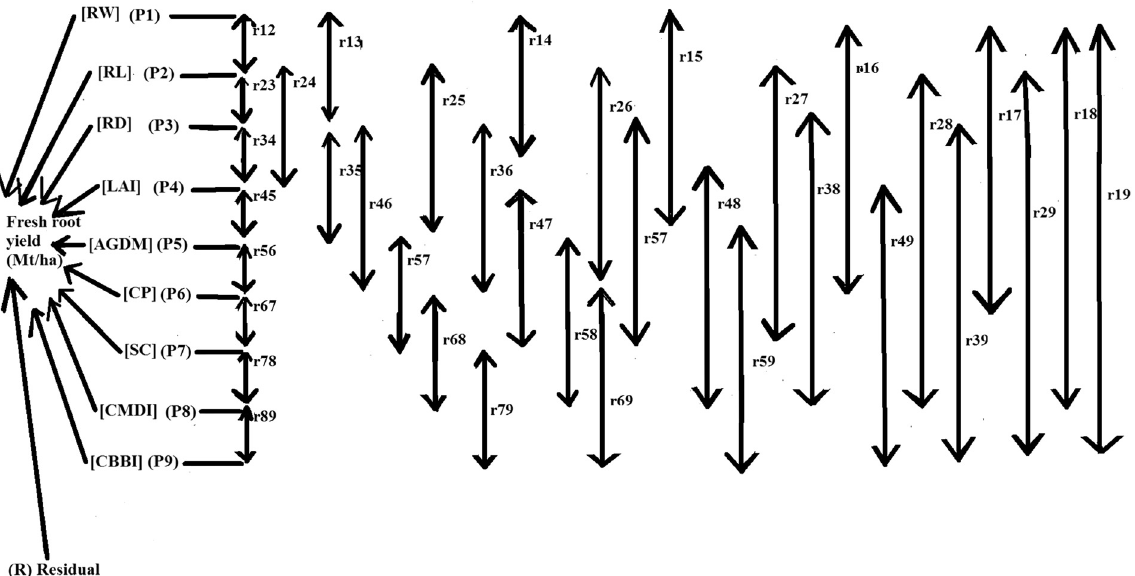
Figure 1: Nature of casual of variables for the path coe ffi cients analysis in twenty - eight cassava genotypes. Residual factor ( R ) , unilateral pathway ( P1 – P9 ) , values of correction coe ffi cients ( r 12 – r 89 ) as obtained from mutual associations between variables of cassava genotypes. Double arrowed lines ( arrowed lines